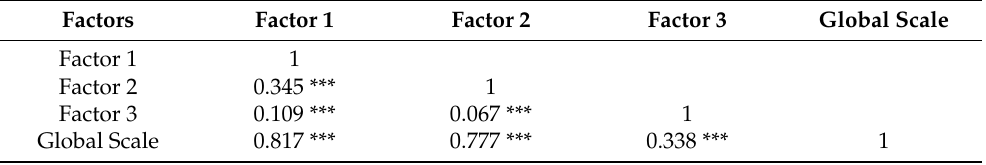
Table 7. Pearson’s correlation matrix between the factors of the Mental Health Knowledge Questionnaire. Factors Factor 1 Factor 2 Factor 3 Global Scale Factor 1 1 Factor 2 0.345 *** 1 Factor 3 0.109 *** 0.067 *** 1 Global Scale 0.817 *** 0.777 *** 0.338 *** 1 *** p < 0.001.